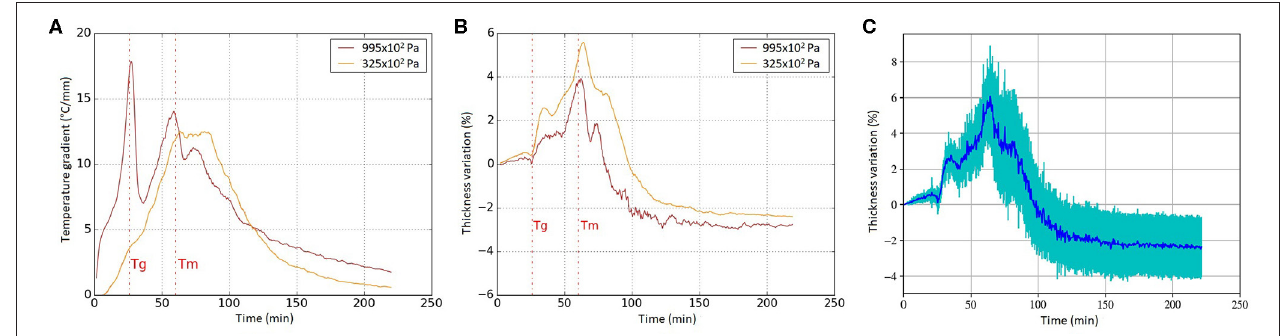
FIGURE 11 | Compaction pressure influence on the consolidation phenomena. (A) Temperature gradient evolution. (B) Thickness evolution. (C) Maximal standard deviation of laminate thickness variations for 3.25 × 10 4 Pa.